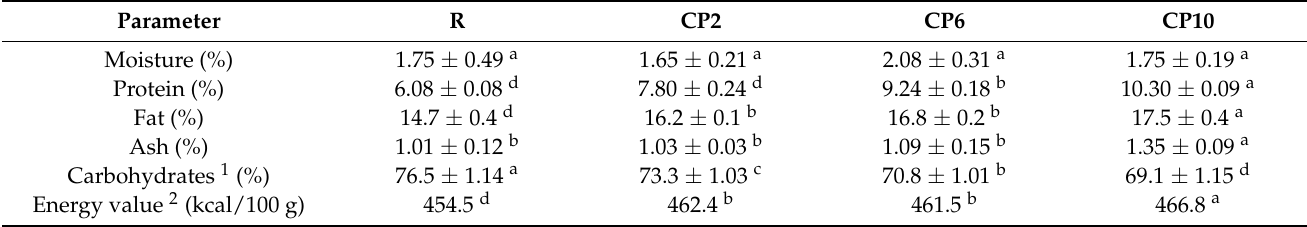
Table 2. Proximate composition and energy value.